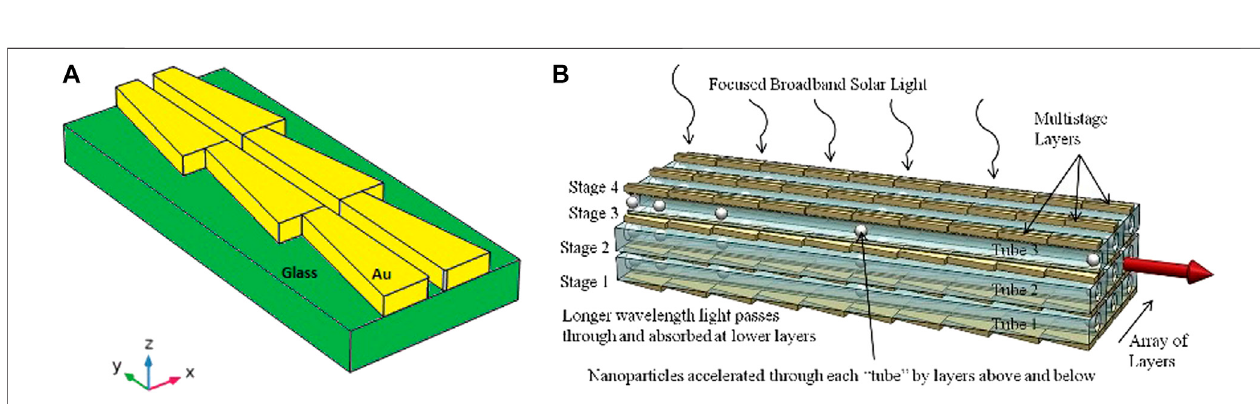
FIGURE 12 | (A) A sketch of the array con fi guration in end-to-end mode; (B) the thruster hypothesised in Rovey et al. (2015) to make full use of sunlight. Adapted from Rovey et al.